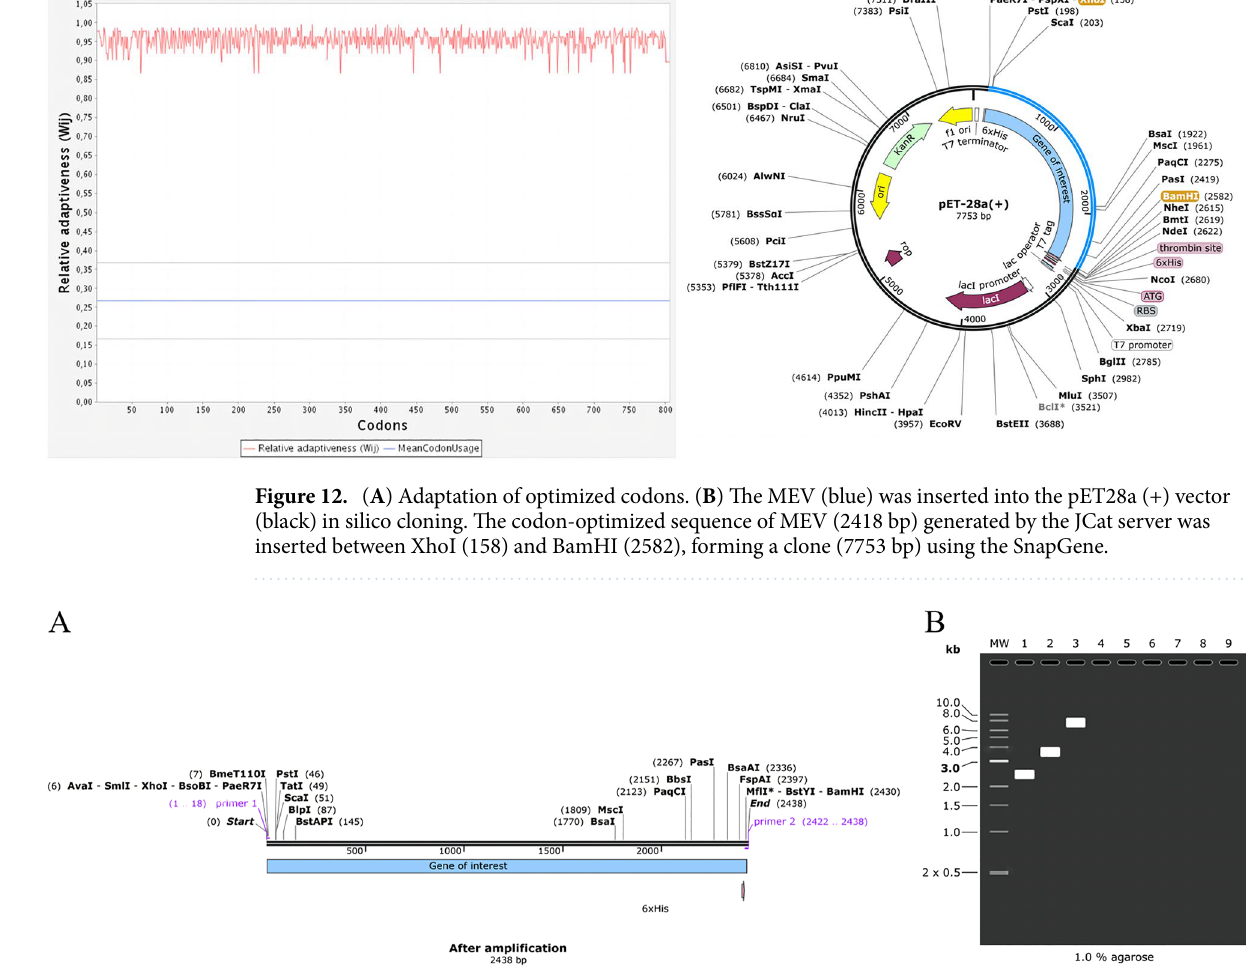
Figure 13. ( A ) The MEV (2438 bp) after amplified. ( B ) Mock agarose gel electrophoresis experiments. As illustrated in the figure, “1” stands for the MEV, “2” stands for pET-28a (+), and “3” stands for recombinant